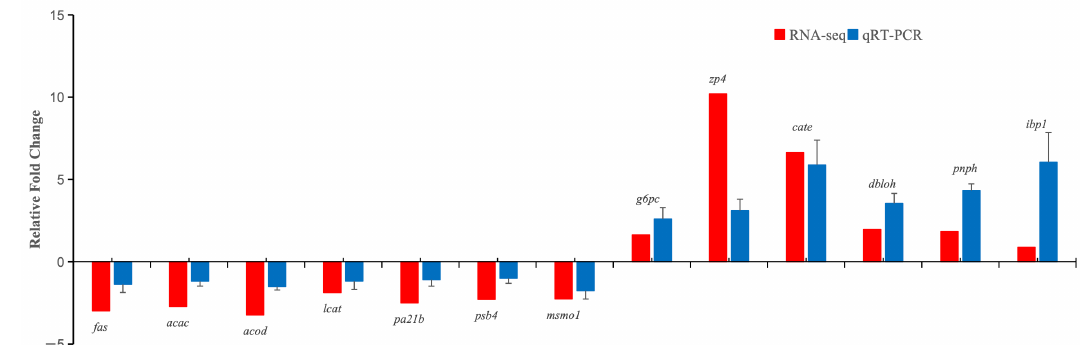
Figure 7. Validation of differentially expressed mRNAs using real-time quantitative PCR (RT-qPCR). Expression levels of selected differentially expressed genes (DEGs) were normalized to 18S rRNA.